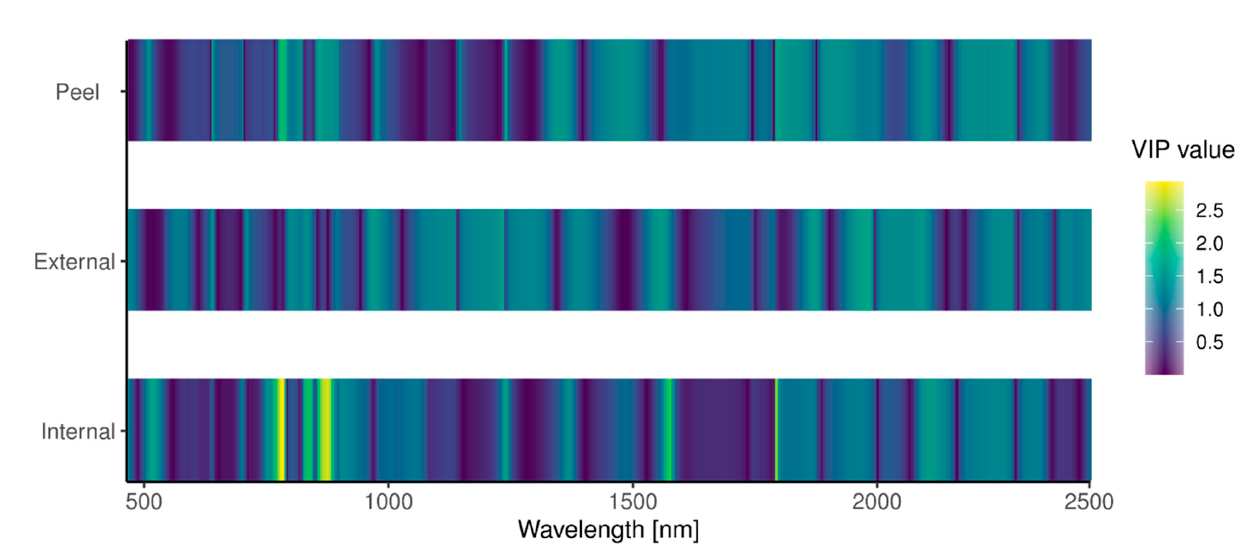
Figure 5. Savitzky–Golay derivative spectra. Left column: distinguishing between healthy and infested tubers; Right column: distinguishing between infestation severity groups. ( a , d ) internal data, ( b , e ) peel data, ( c , f ) external data.